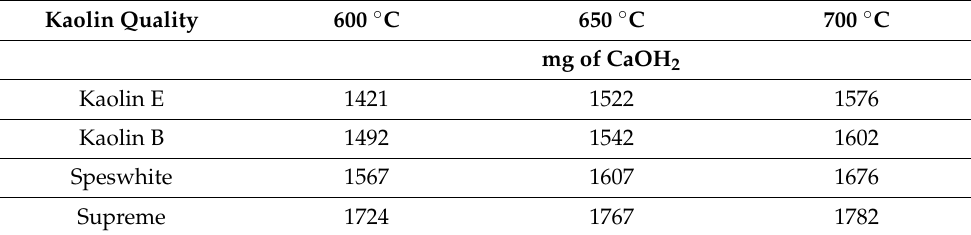
Table 1. Chapelle test results for the raw materials and the calcined samples.